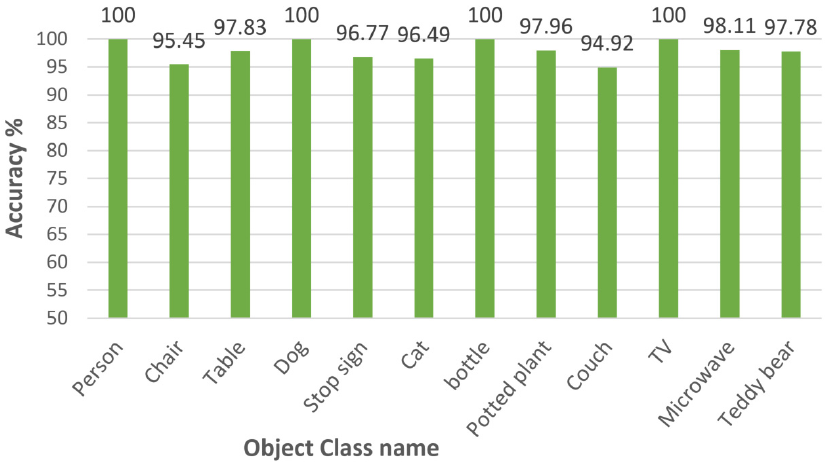
Figure 14. Individual class classification accuracy.